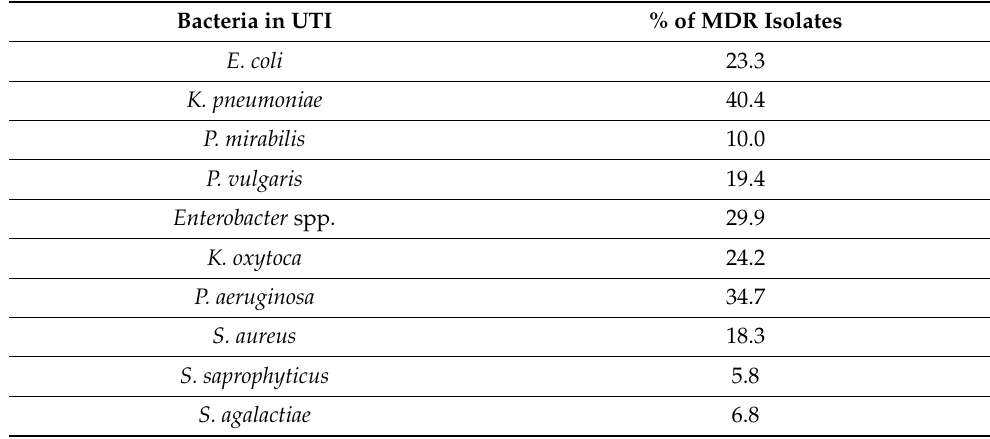
Table 6. Percentage of multidrug resistance in the studied